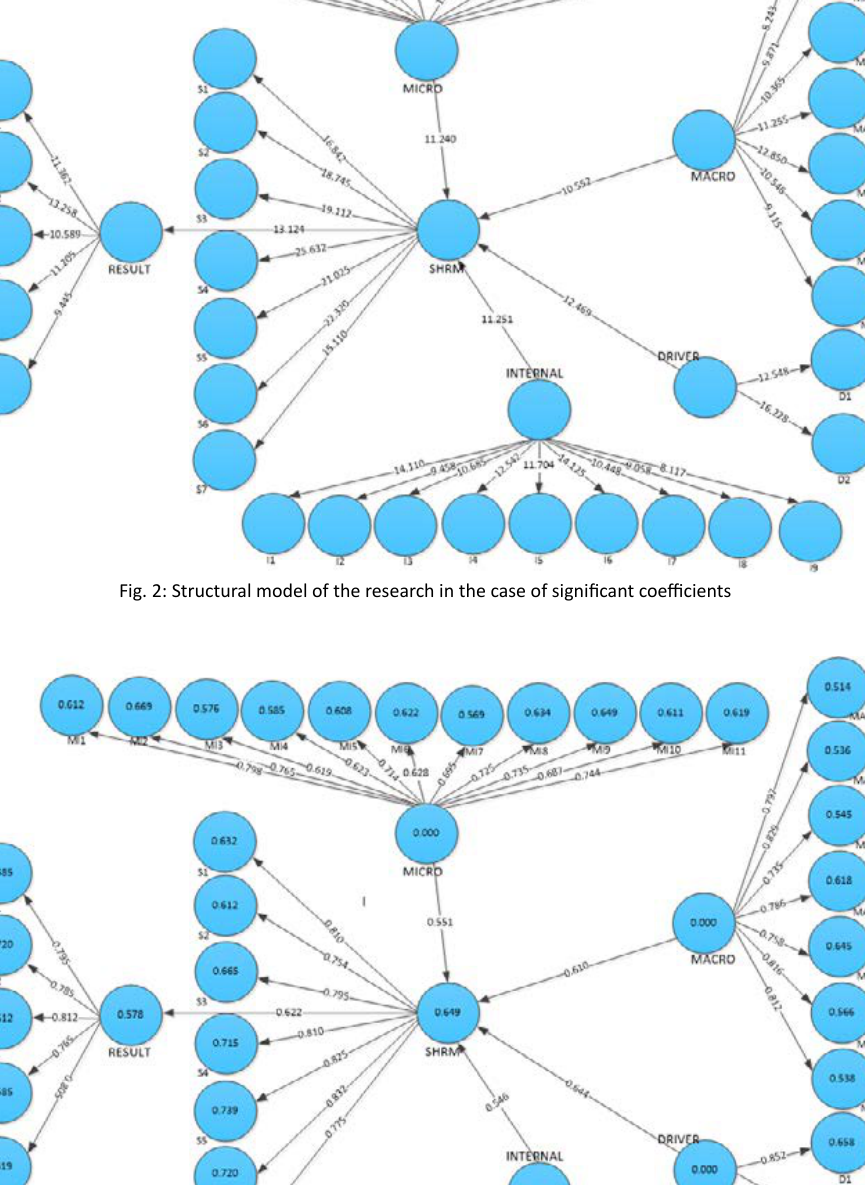
Fig. 3: Structural model of research in the standard mode